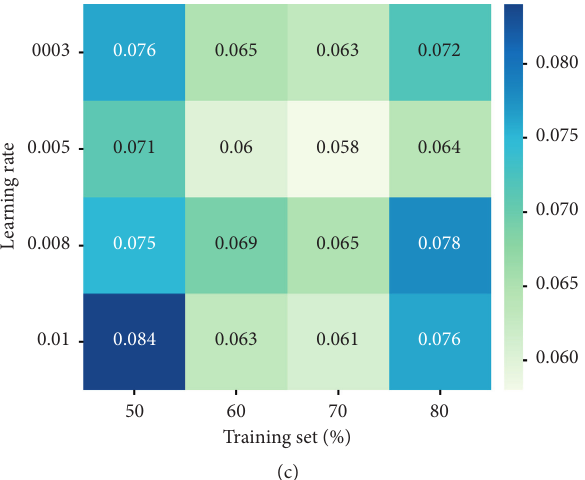
Figure 8: The RMSE value of UWM-Id under different parameter combinations, (a) the training set and optimizer, (b) the learning rate and optimizer, and (c) the learning rate and training